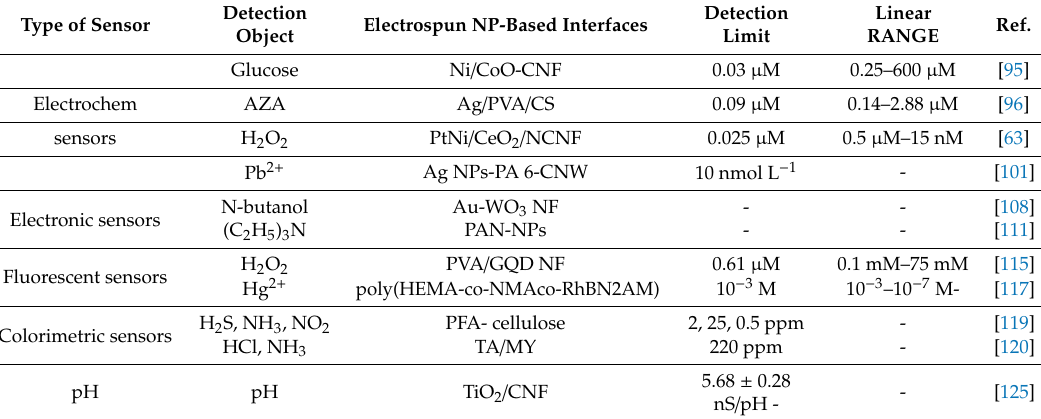
Table 2. Summary on the electrospun materials interfaces for various